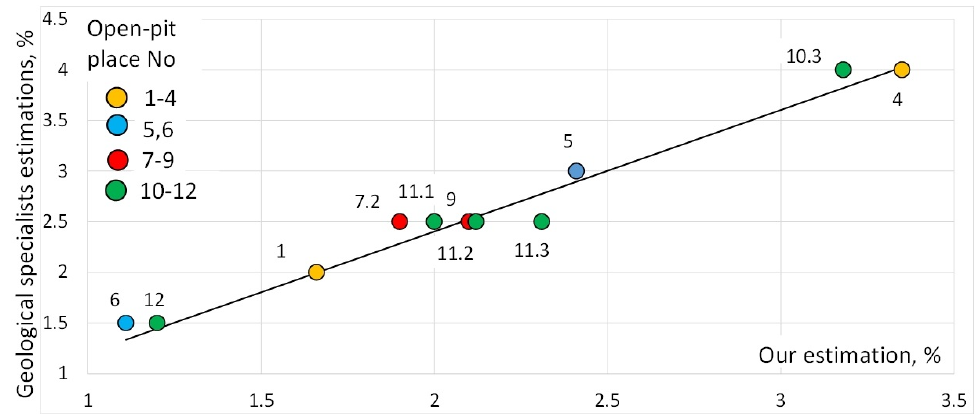
Figure 14. The graduation curve of our and experts estimated asbestos content values The graduation (approximation) line in Figure 14 is obtained using the method of least squares. The line coefficients are: k = 1.2, b = 0.003, with R 2 = 0.973. The results are depicted on the graduation line with scatter up to